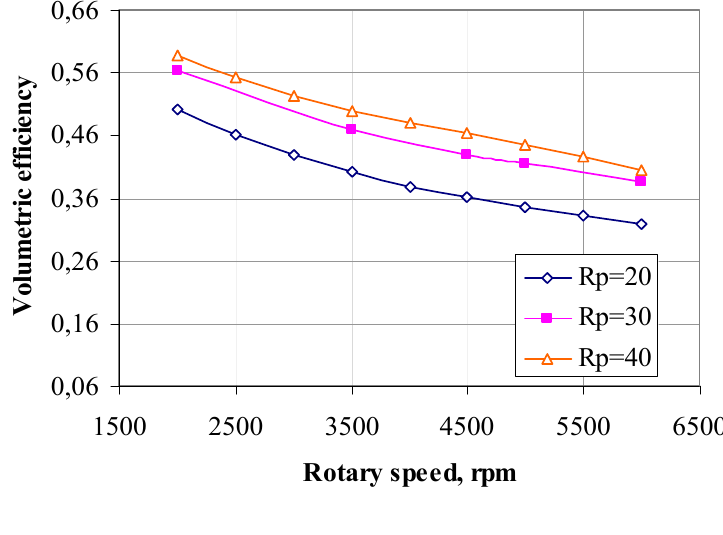
Figure 9. Evolution of the volumetric efficiency at different pressure ratios and rotary